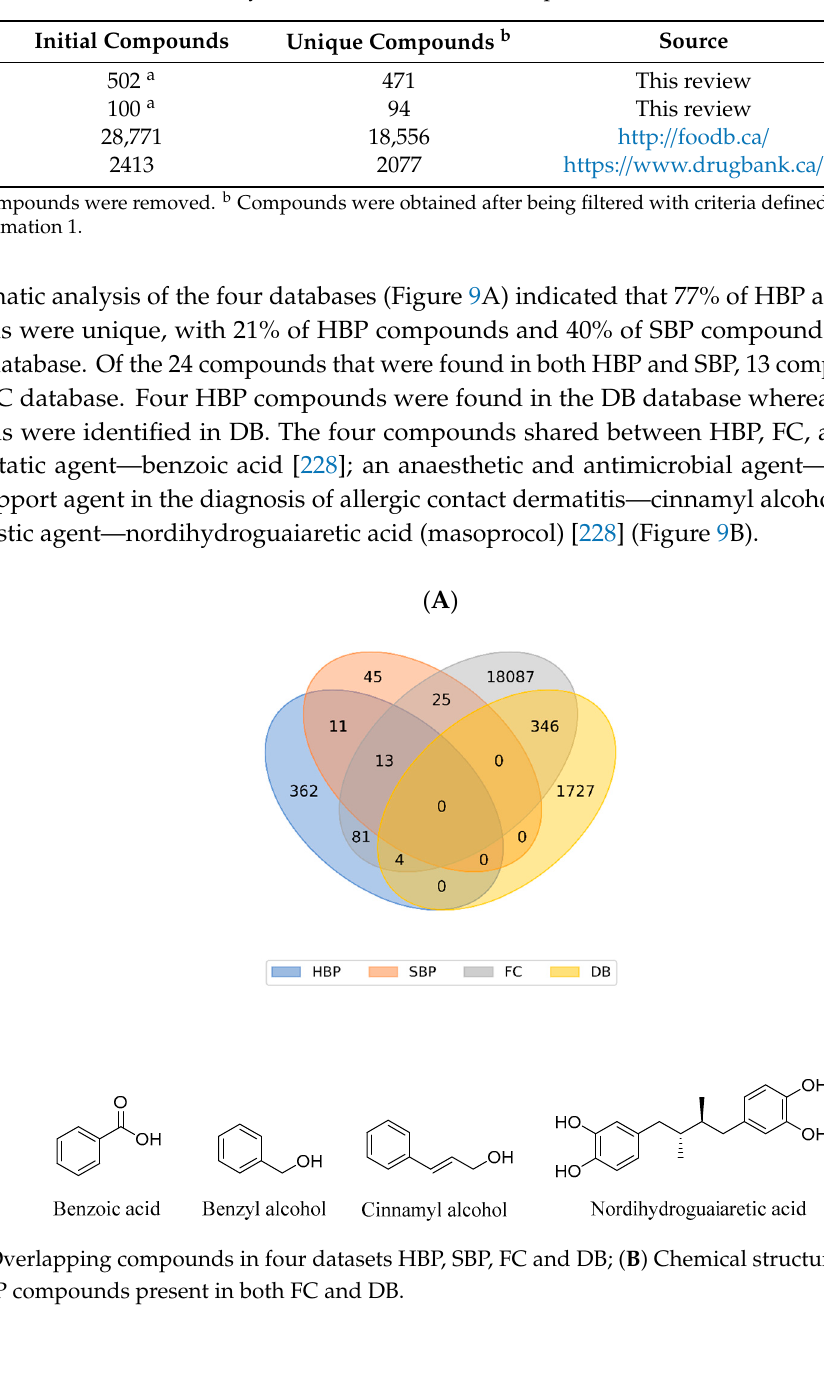
Table 3. Summary of the datasets used for comparison.